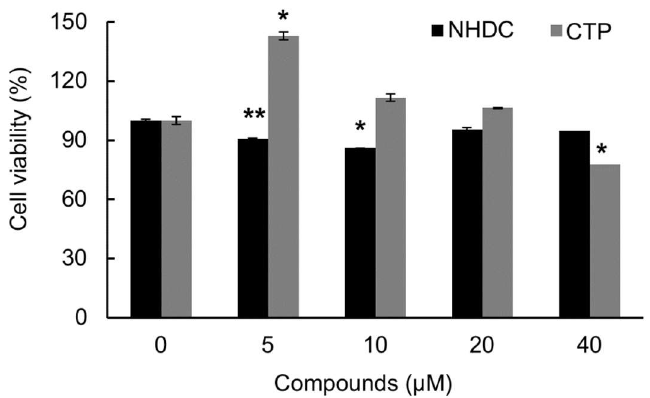
Figure 2. Viability of human adipose-derived stem cells (hASC) in the presence of NHDC and its analogue. Human adipose-derived stem cells (hASCs) were seeded onto a 96-well plate, and the cells were treated with different concentrations (5, 10, 20, and 40 µM) of NHDC and CTP for 5 days. The cell viability was measured by MTS assay. The results are expressed as the mean values ± SD ( n = 3); * p < 0.01, ** p < 0.05 as compared to non-treated group (0 µM).